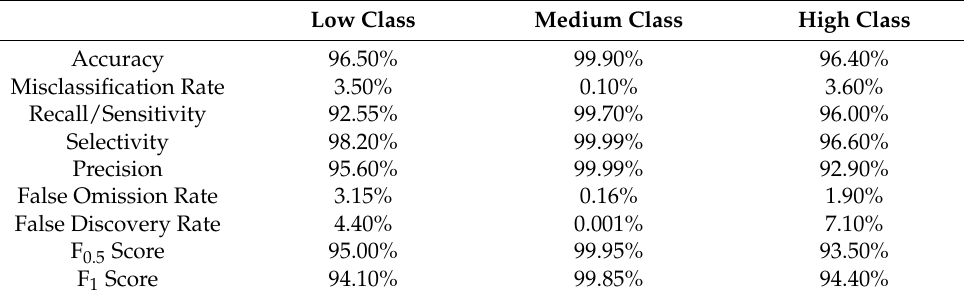
Table 3. Comparison of statistical parameters for the three classes.